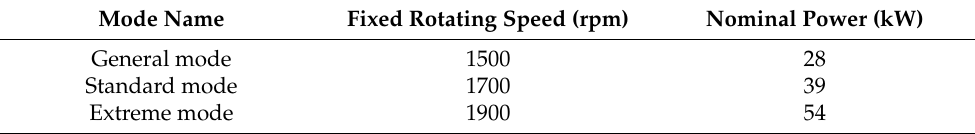
Table 2. Working motor theoretical parameters of the three modes.